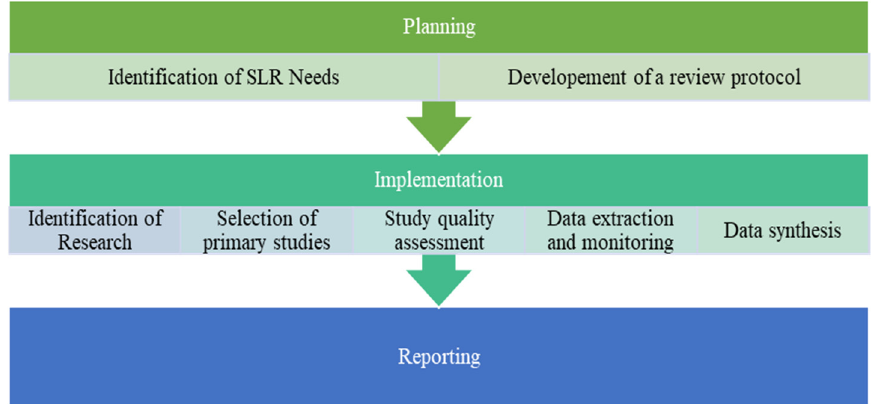
Figure 1. Systematic literature review (SLR) methodology.